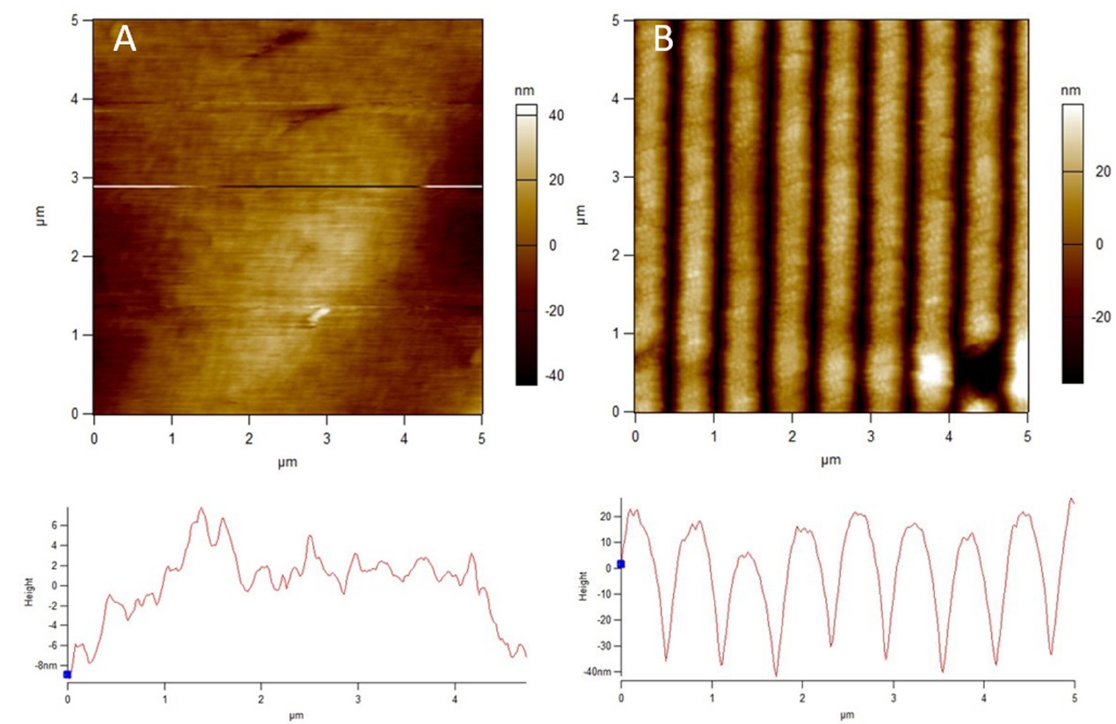
Figure 1. AFM images and cross-sectional profiles of a ( A ) pristine and ( B ) patterned NF270 membrane. The common scale is 5 μ m × 5 μ m.